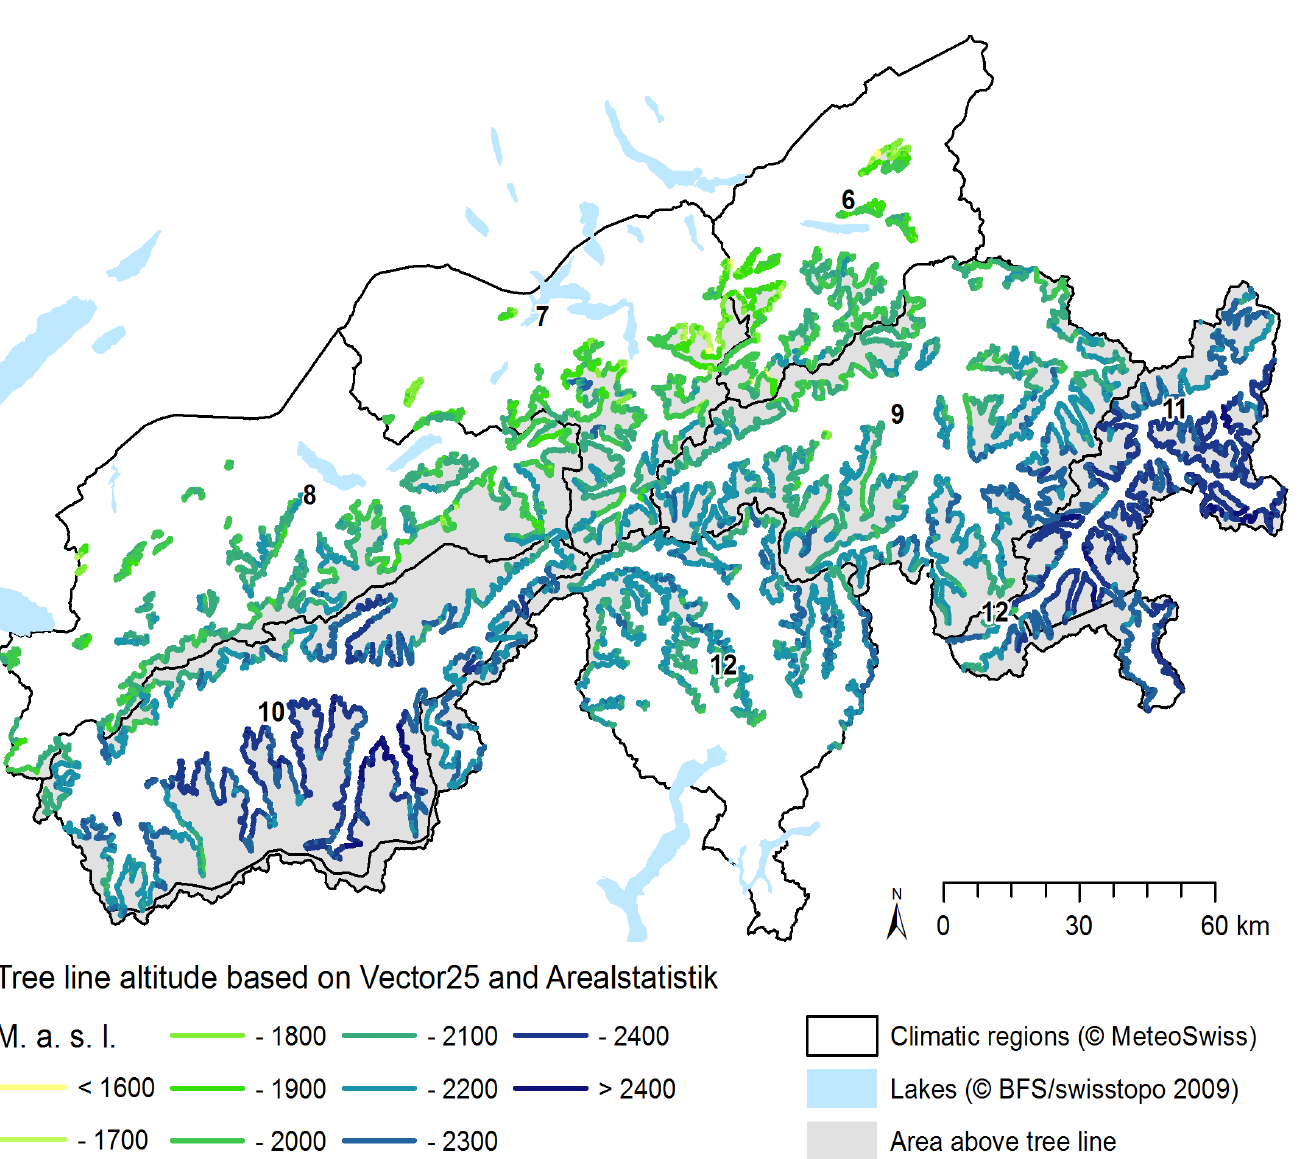
Figure 7. The tree line altitude is shown in categories. It rises from the isolated peaks and ridges to the shielded side valleys of the Valais (10) and the Engadin